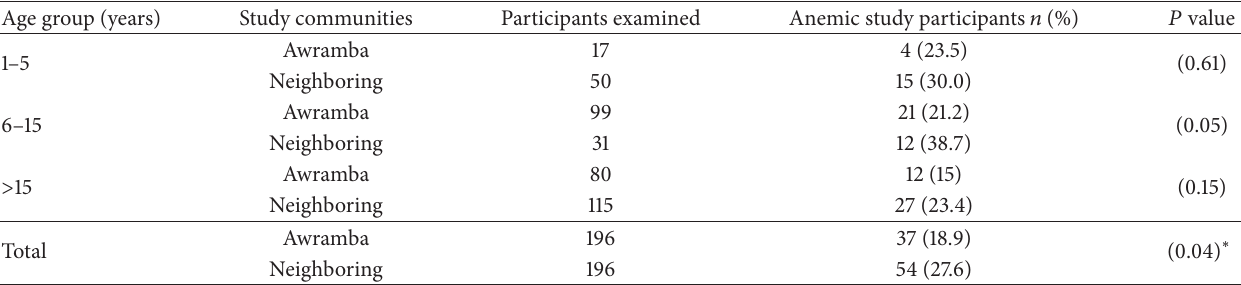
Table 3: Prevalence of anemia among different age groups of Awramba and its neighboring communities in Fogera Woreda, South Gondar Zone, Ethiopia (November 2010–April 2011).